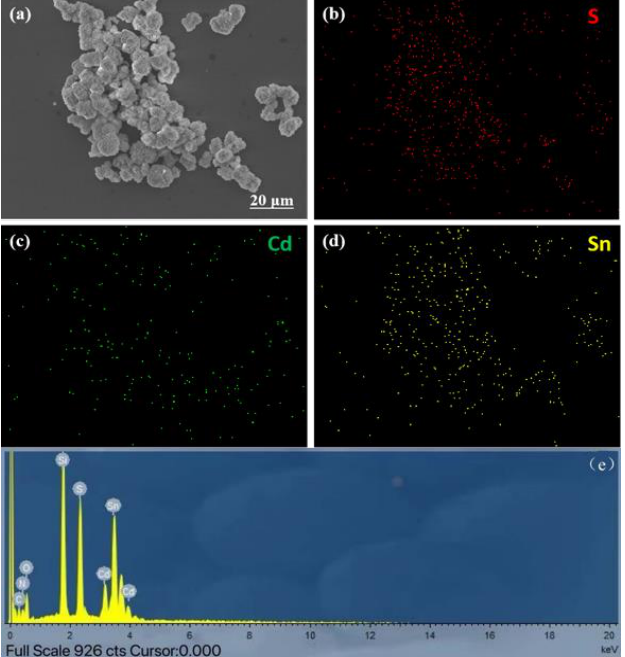
Figure 3. ( a ) SEM image; EDS mapping images of ( b ) S, ( c ) Cd and ( d ) Sn; and ( e ) EDS spectrum of